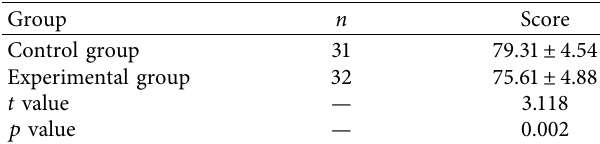
Table 4: Comparison of the theoretical examination results of clinical anesthesiology between experimental group and control